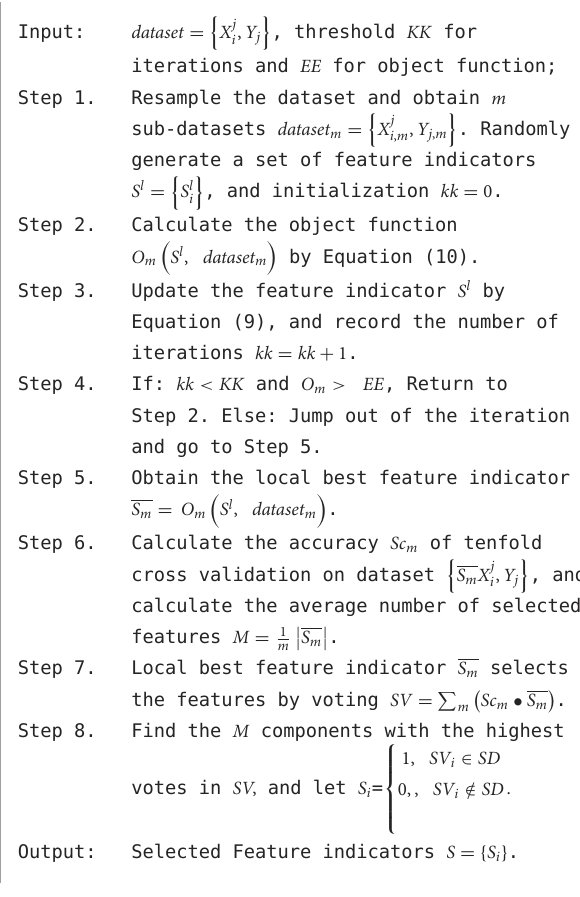
Algorithm 1. SVM-based feature